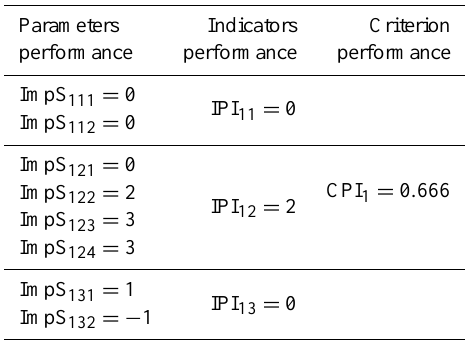
Table 4. Some illustrative impact scores with the resulting IPIs and